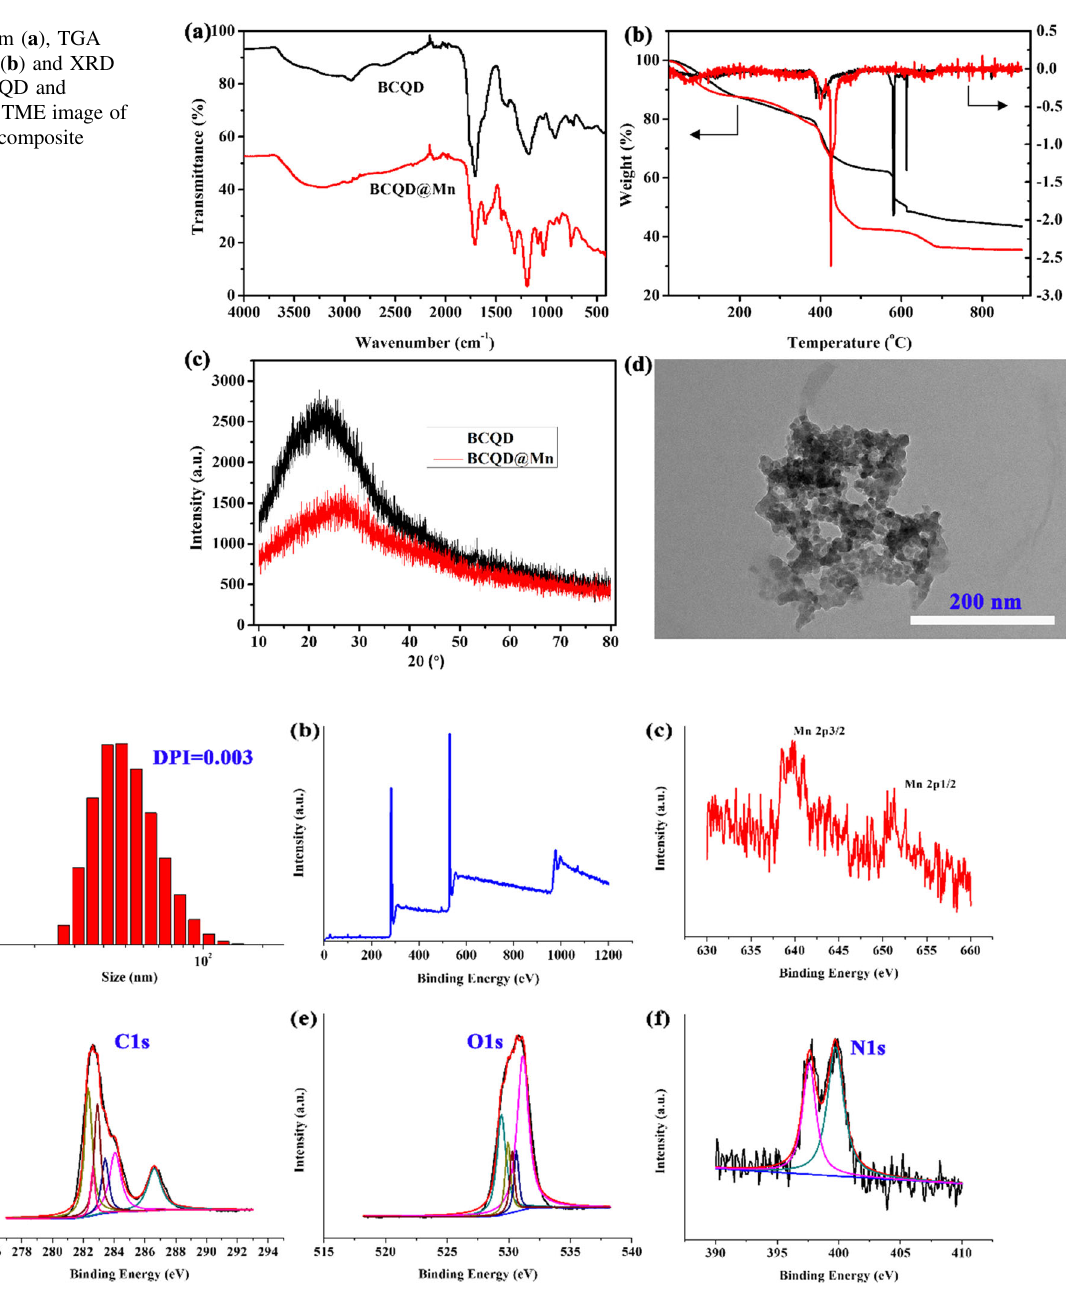
Fig. 2 DLS curve ( a ) and XPS spectra of the BCQDs@Mn composite: ( b ) survey spectra, ( c ) Mn 2p, ( d ) C 1s, ( e ) O 1s, ( f ) N